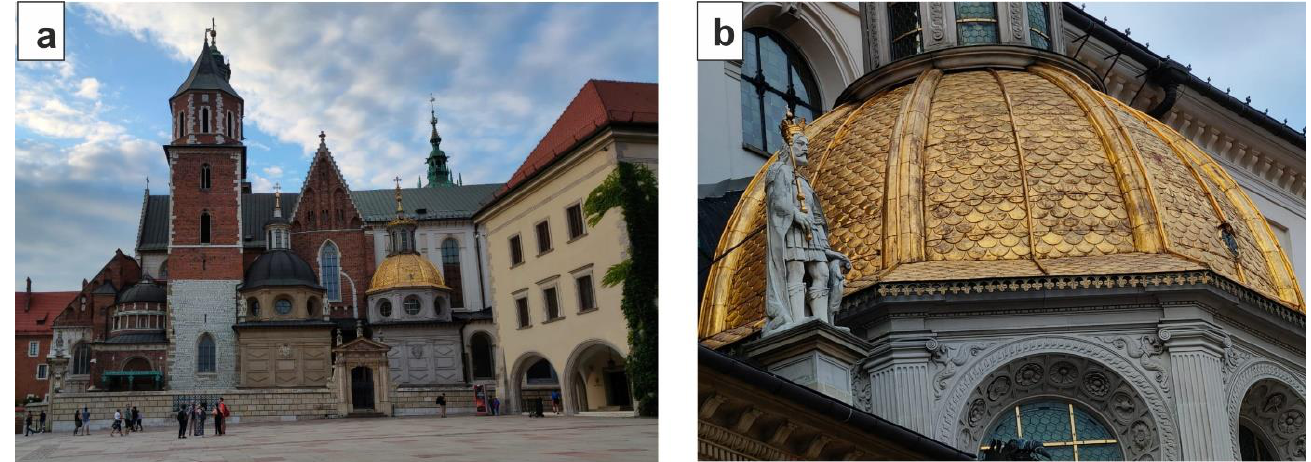
Figure 8. Chapel of Zygmunt in the Wawel Cathedral in Kraków, Poland, with a dome covered with gold extracted from the Miedzianka Mountain ore deposit. ( a ) Distant view and ( b ) close-up view of the dome.